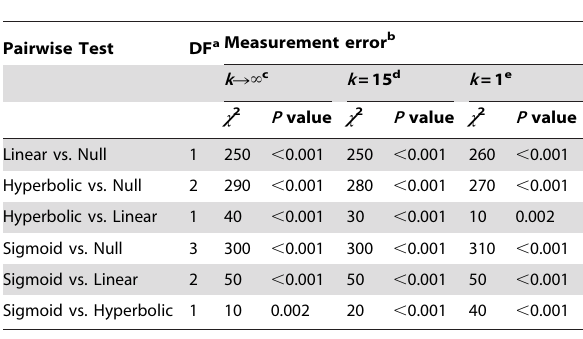
Table 5. Pairwise likelihood-ratio test chi-square values comparing the fit of dose-response